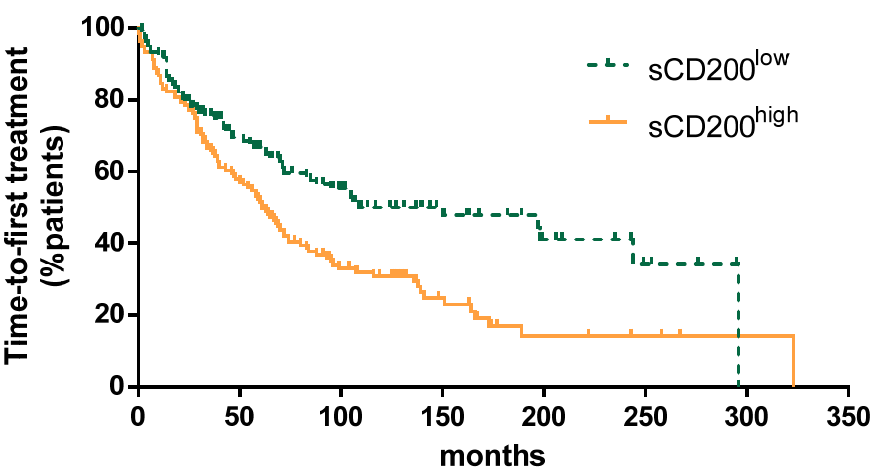
Figure 2. Time-to-first treatment for patients with sCD200 low vs. sCD200 high .